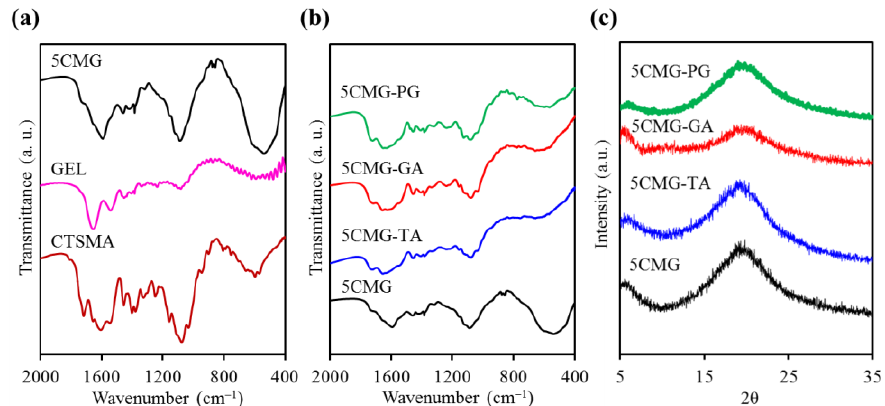
Figure 7. ( a , b ) FTIR spectra in transmittance mode of various samples and ( c ) XRD patterns of 5CMG with and without phenolic compounds (TA, GA, and PG).